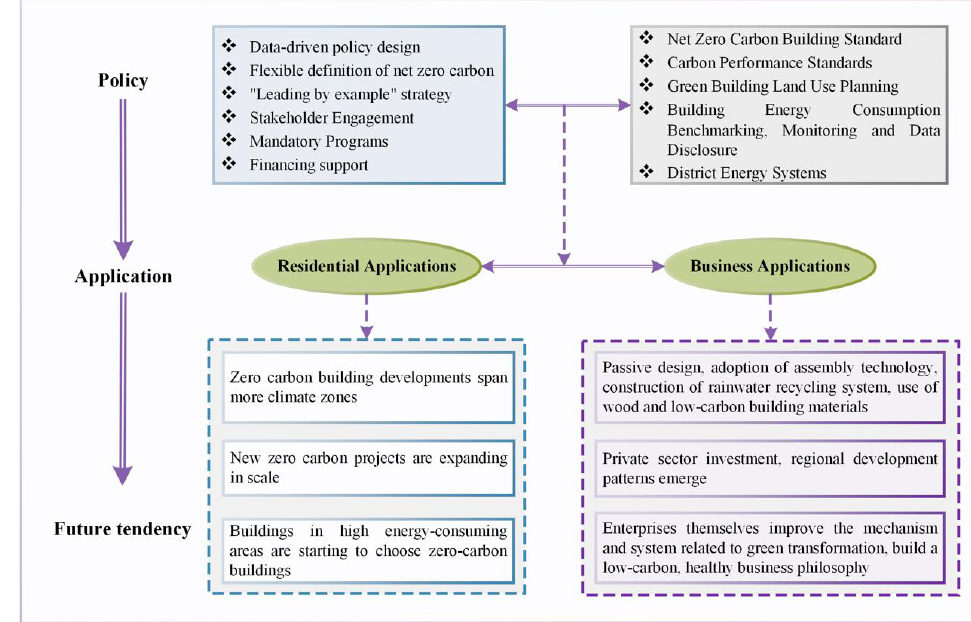
Figure 9. Development focus and trends in zero-carbon building research.